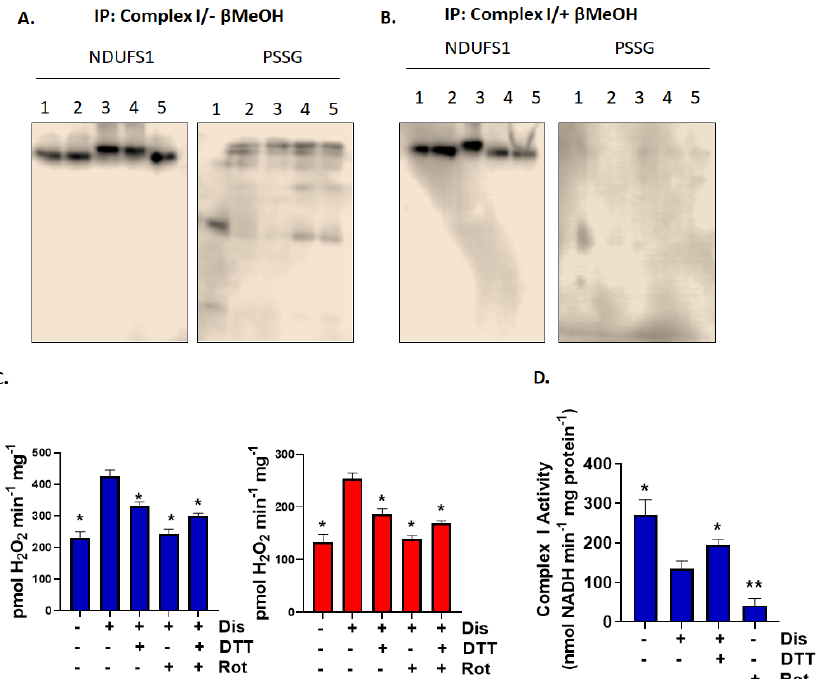
Figure 6. Modification of NDUFS1 in complex I accounts for the increased production of ROS in liver mitochondria oxidizing G3P and Pro. ( A ) Diamide and disulfiram treatment results in the glutathionylation of NDUFS1 subunit of complex I. Mitochondria were exposed to (1) control conditions (no glutathionylation catalyst), (2) 1000 µ M diamide, (3) 5000 µ M diamide, (4) 5000 nM disulfiram, and (5) 10,000 nM disulfiram and then complex I was immunoprecipitated according to the manufacturer’s instructions. ( B ) Mitochondria treated with β -mercaptoethanol served as a control to verify PSSG anti-serum specificity. NDUFS1 was also detected to demonstrate it was successfully immunocaptured. ( C ) Reversal of glutathionylation diminishes ROS production in mitochondria oxidizing G3P or Pro. Mitochondria were treated with 1000 nM disulfiram + 1 mM GSH, washed several times, and incubated with DTT. Rotenone was also added to some reactions as a control. N = 4, mean ± SEM, 1-way ANOVA with a post-hoc Fisher’s LSD test. * p ≤ 0.05. ( D ) DTT treatment restores the activity of complex I after treatment with disulfiram. Mitochondria were incubated in disulfiram + GSH as described in C. and then DTT was added. N = 4, mean ± SEM, 1-way ANOVA